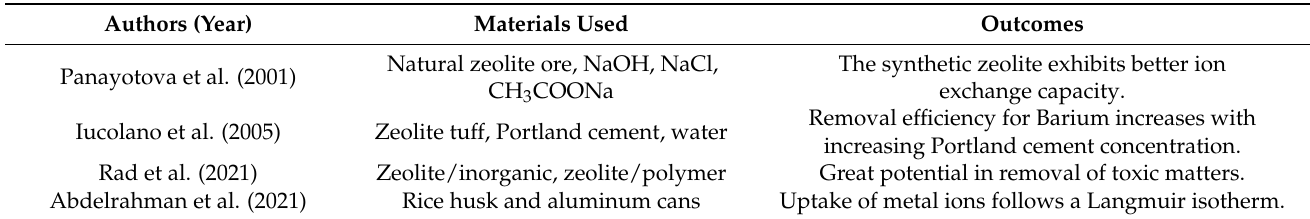
Table 6. Recent studies on synthetic zeolites for ion removal.